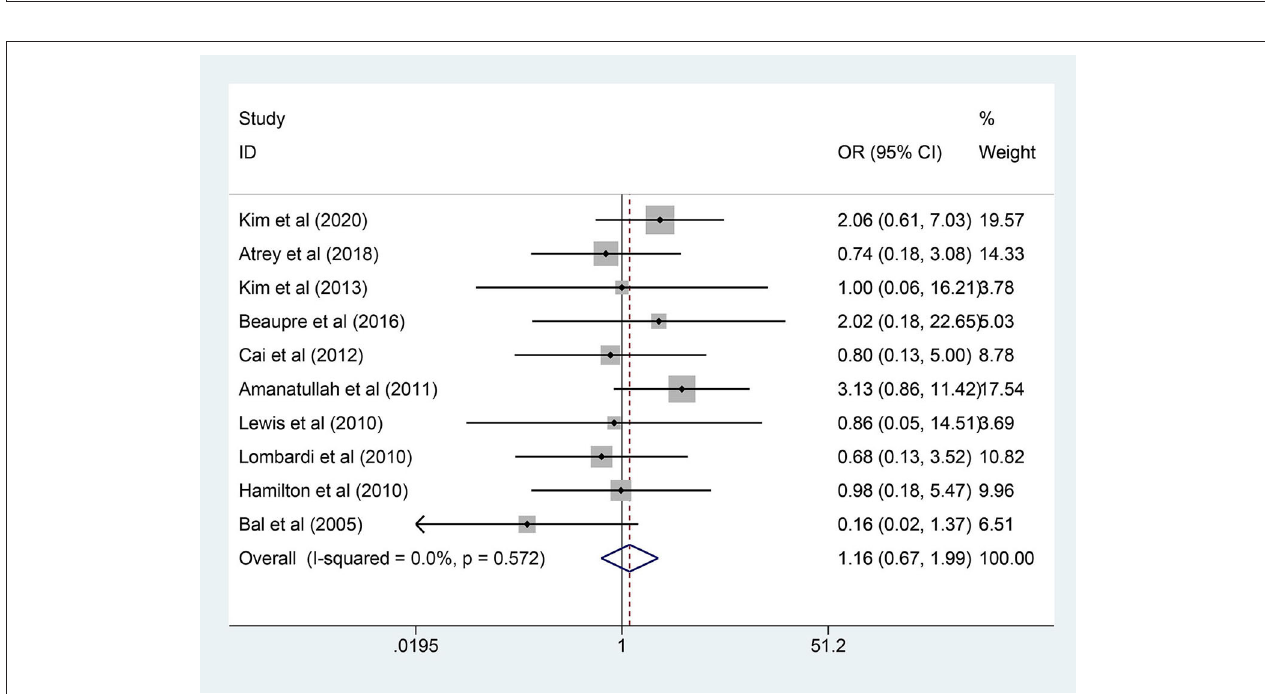
FIGURE 3 | Forest plot diagram of the prosthesis fracture rate of the replaced hip with COC and COP bearing surfaces.